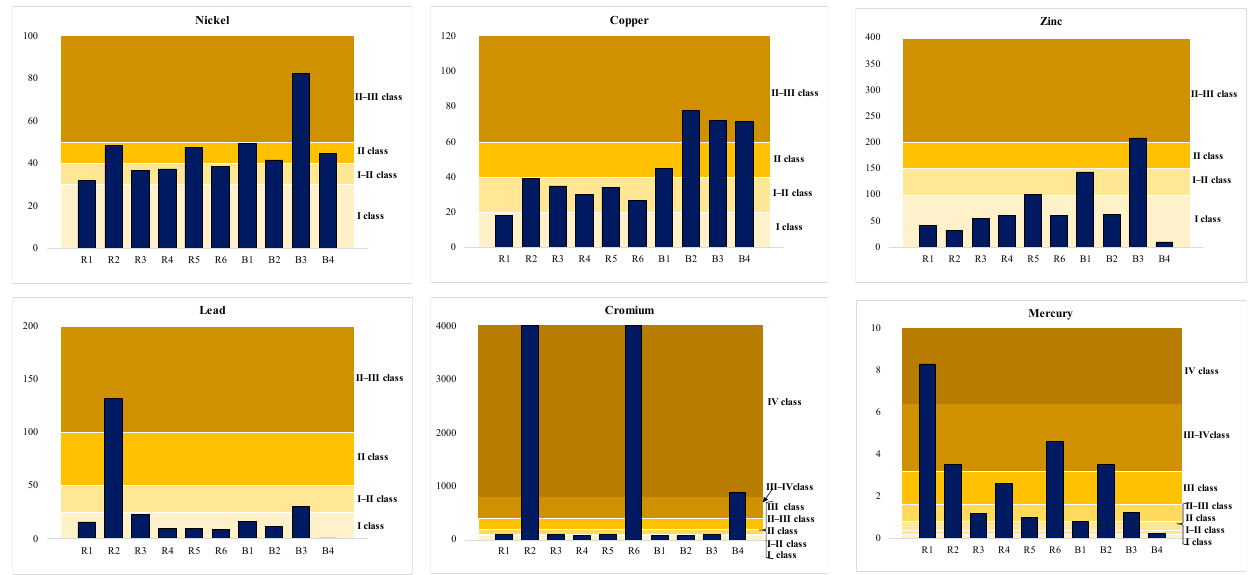
Figure 8. LAWA quality classes for sediments.